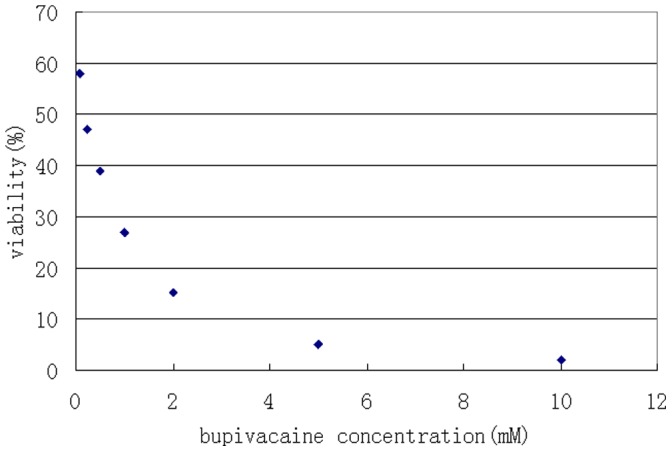
The effect of increasing concentrations of bupivacaine on SH-SY5Y cell viability.SH-SY5Y cells were exposed to different concentrations of bupivacaine (0.1, 0.5, 0.75, 1, 2, 5, and 10 mM). The viability of the cells declined with increasing bupivacaine concentration.